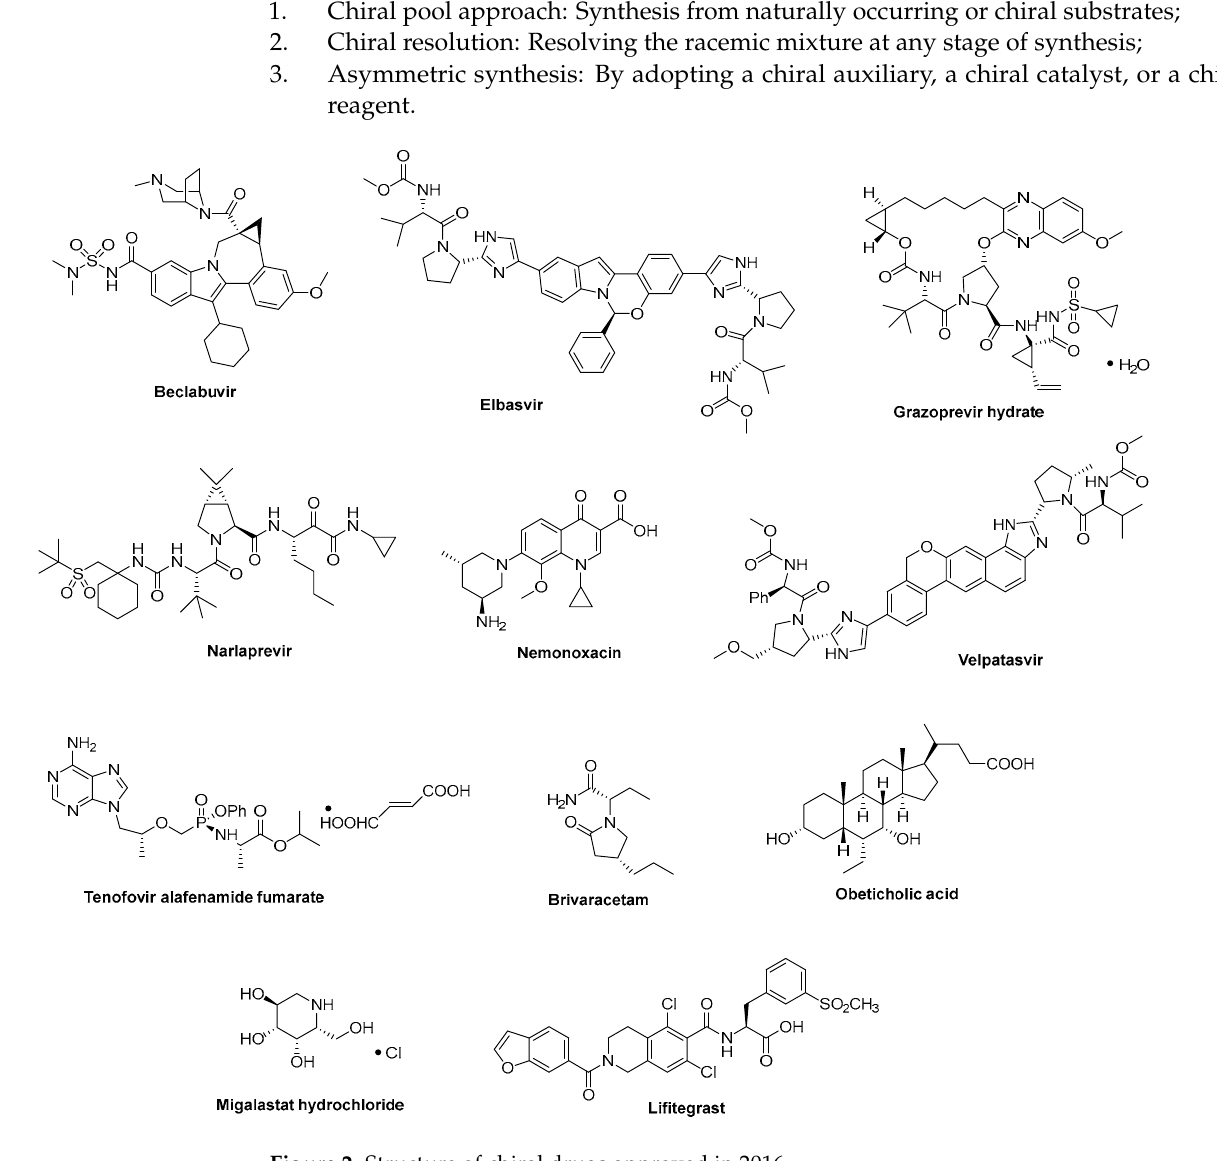
Figure 2. Structure of chiral drugs approved in 2016.